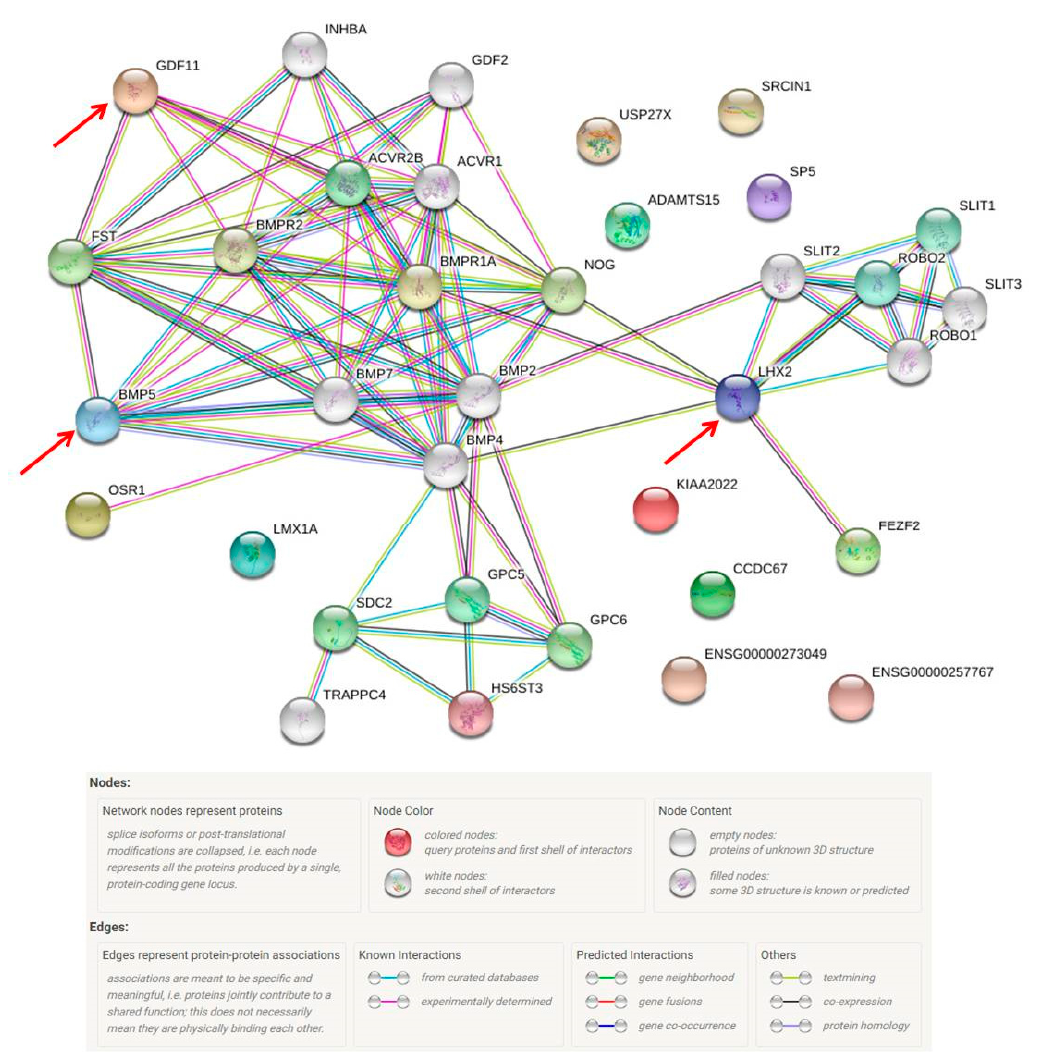
Figure 8. The protein–protein interaction pathways are illustrated. Twenty-nine proteins were identified from the missing protein database to be related with HBX. LHX2, BMP5 and GDF11 are inter-connected with other proteins.